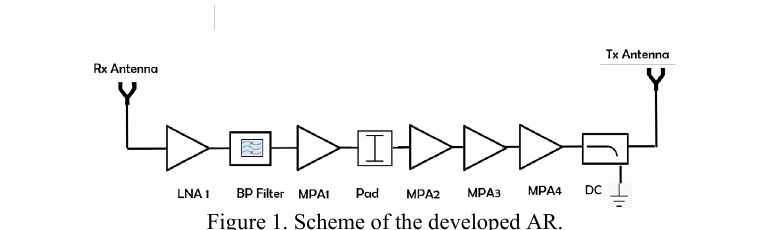
Figure 1. Scheme of the developed AR.